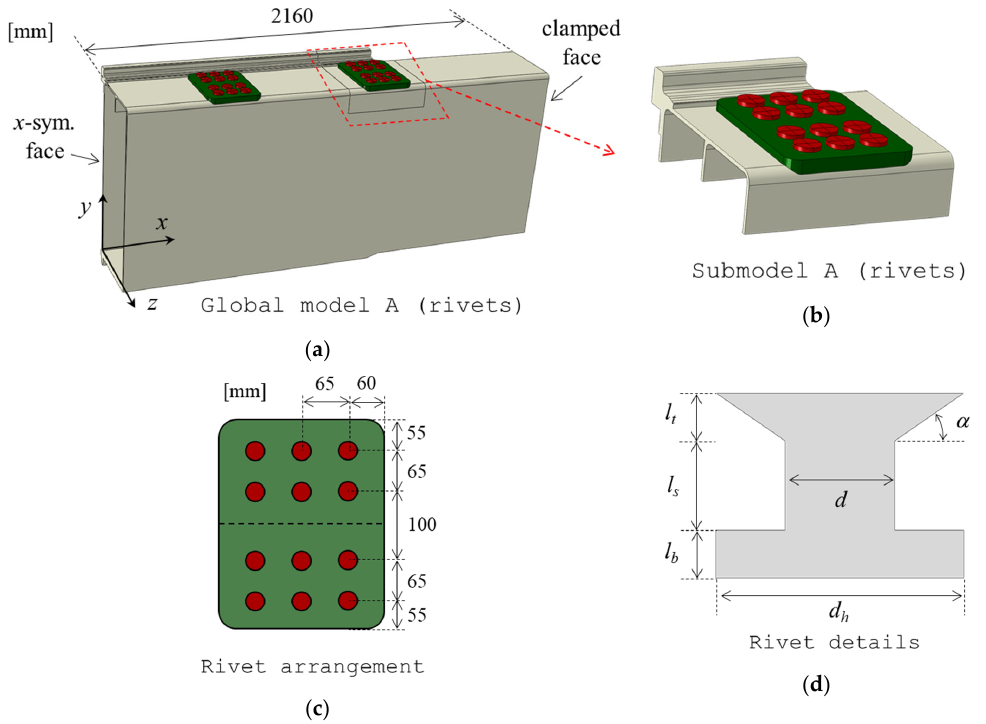
Figure 10. Model A for the riveted configuration showing: ( a ) the global model, ( b ) the submodel, ( c ) the rivet arrangement, and ( d ) the dimensions of the rivet. Table 4. Material properties for the S600MC and S900MC steels.